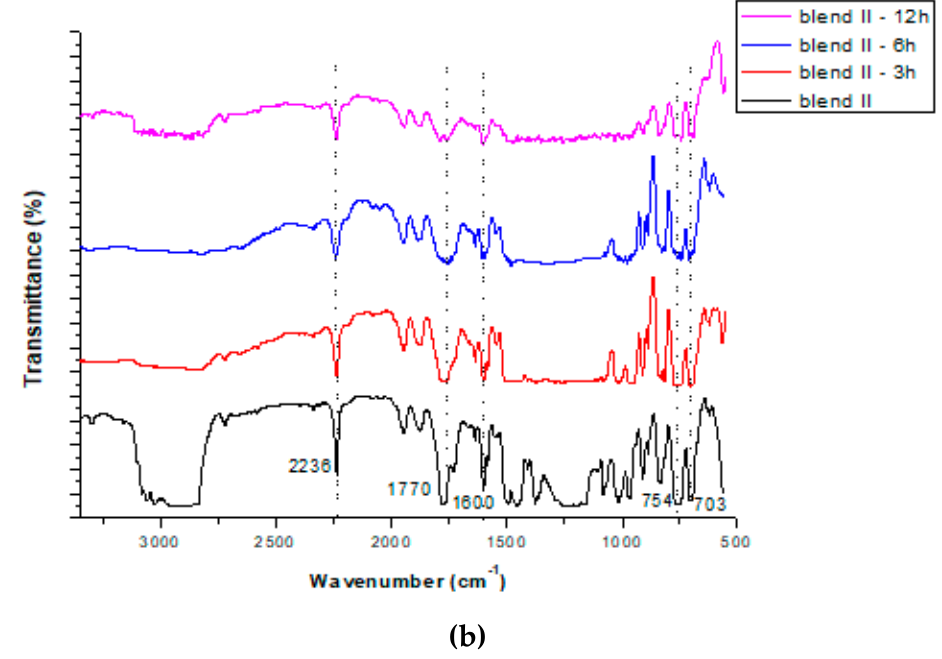
Figure 1. FTIR spectra of the two polymeric blends: blend I ( a ) and blend II ( b ) before pretreatment and after soxhlet extraction with isopropanol at different extraction times: 3, 6 and 12 h.